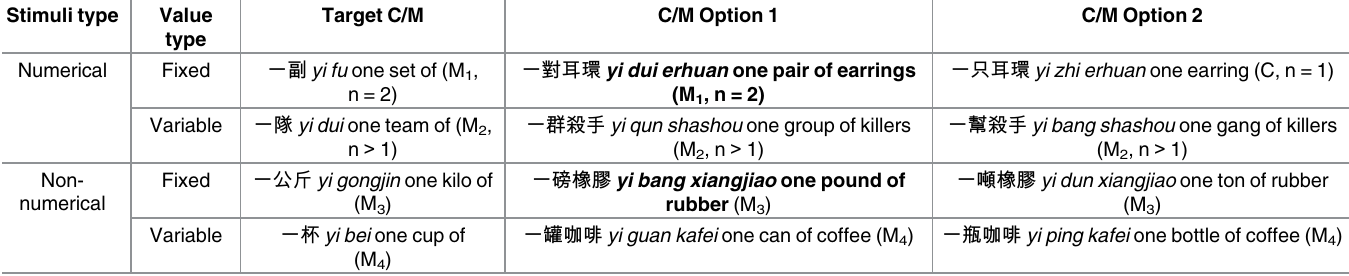
Table 3. Structure of the experimental stimuli with a sample set for each